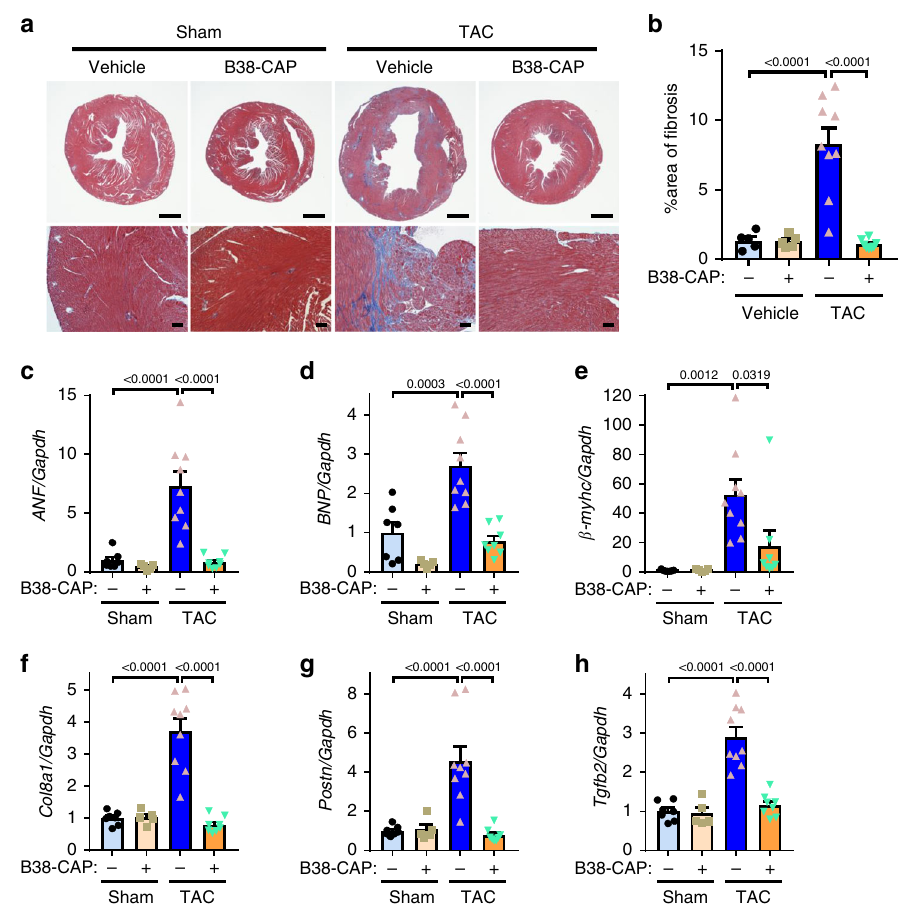
Fig. 5 B38-CAP suppresses TAC-induced cardiac fi brosis. a , b Histology. The hearts of B38-CAP or vehicle-treated mice under TAC were stained with Masson ’ s trichrome. Bars indicate 1 mm (upper) or 100 μ m (lower). c – h qRT-PCR analysis for the expression of heart failure genes and pro- fi brosis genes; mRNA levels of atrial natriuretic factor ( ANF ) ( c ), B-type natriuretic peptide ( BNP ) ( d ), β -myosin heavy chain ( β -myhc ) ( e ), Collagen 8a ( Col8a1 ) ( f ), Periostin ( Postn ) ( g ), and TGF- β ( Tgfb2 ) ( h ) in the hearts of mice treated with sham + vehicle ( n = 7), sham + B38-CAP ( n = 5), TAC + vehicle ( n = 9), and TAC + B38-CAP ( n = 8). All values are means ± SEM. b – h Two-way ANOVA with Sidak ’ s multiple-comparisons test. Numbers above square brackets show signi fi cant P -values.